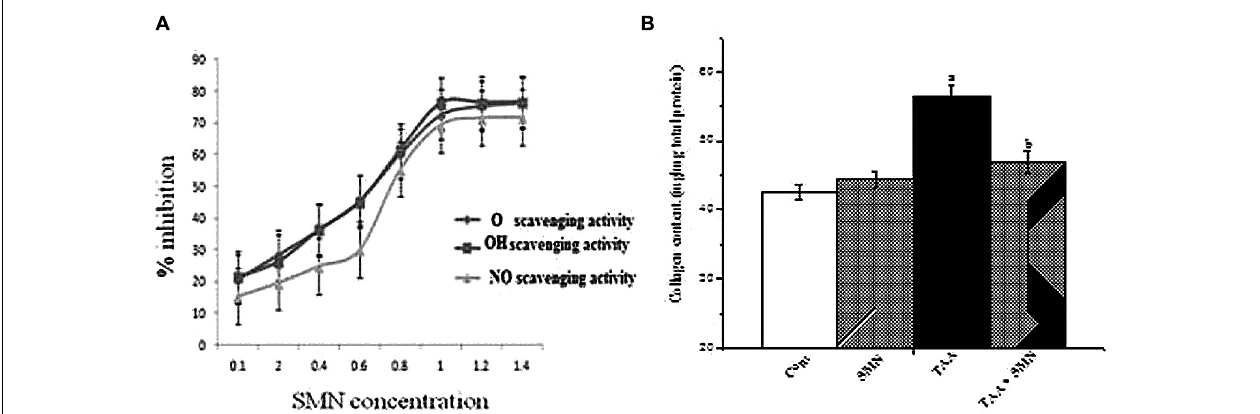
FIGURE 4 | (A) DNA [isolated from liver (A) and kidney (B) ] fragmentation pattern on agarose/EtBr gel. Lane 1 marker (1 kb DNA ladder), lanes 2, 3, 4, and 5 DNA isolated from normal, SMN treated, TAA administered, SMN post-treated mice, respectively. Arrows indicate ladder formation. SMN decreased all the TAA-induced pro-apoptotic events in hepatic and renal tissue.